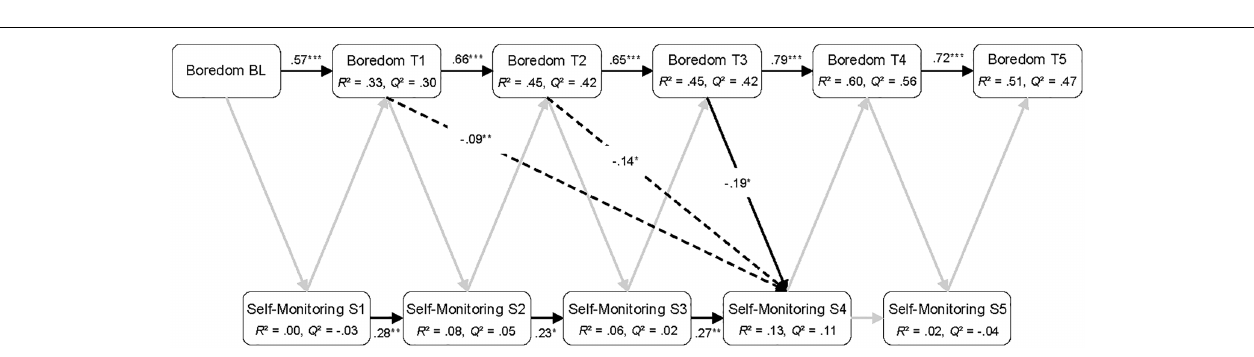
FIGURE 4 | Sequential PLS-PM analysis showing all direct and the significant indirect paths between enjoyment and self-monitoring. BL, baseline measurement; T1 to T5, five measurement occasions during playing Cure Runners ; S1 to S5, five sections of Cure Runners . Black lines, significant direct paths; gray lines, non-significant direct paths; dashed lines, significant indirect paths. n = 88. ∗ p < 0.05, ∗∗ p < 0.01, ∗∗∗ p < 0.001.